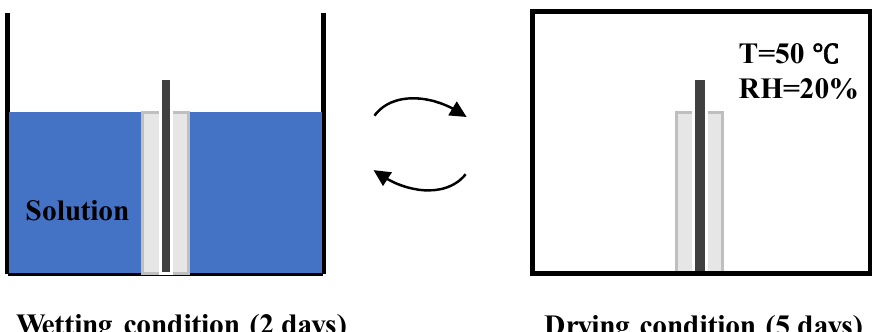
Figure 2. Schematic diagram of the drying–immersion cycles employed in this study.